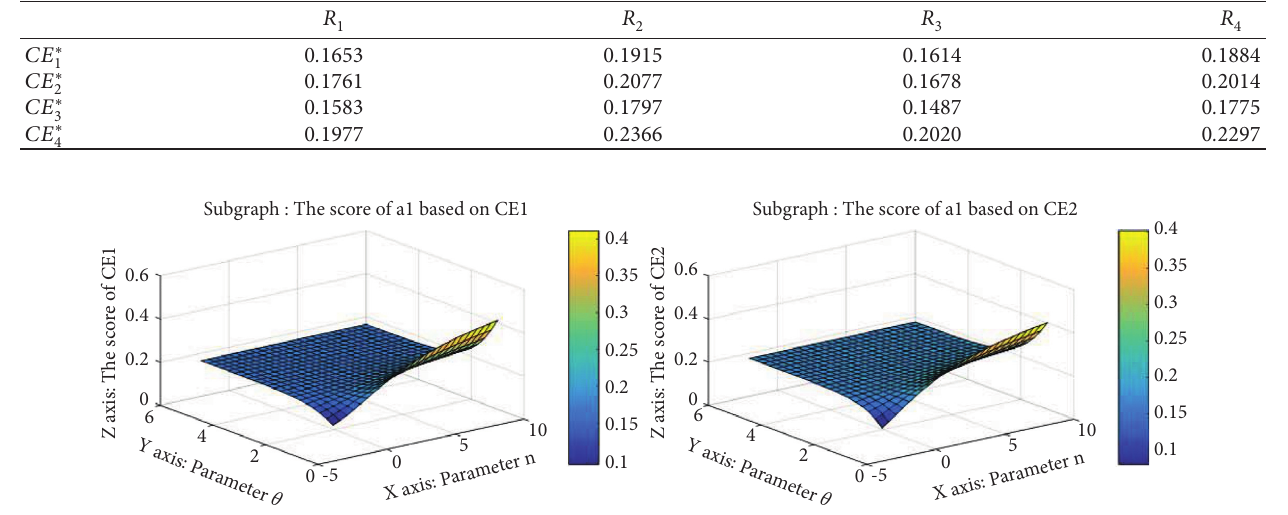
Table 2: Score of each alternative.